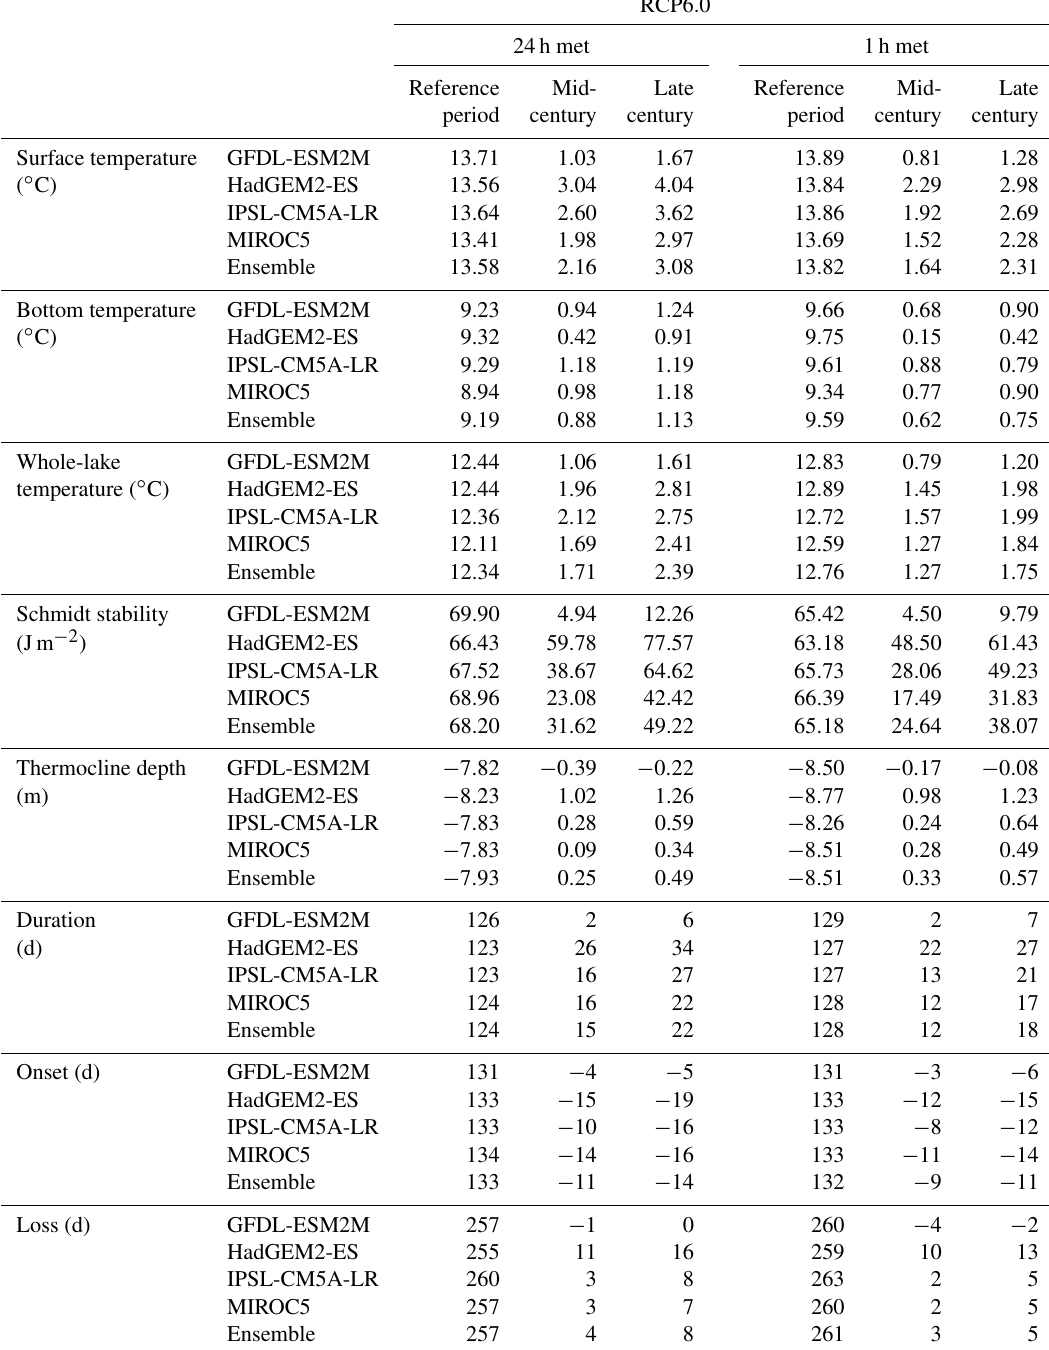
Table 6. Average thermal metrics for the reference period (1981–2010), and average projected change in thermal metrics for the mid-century and the late century for